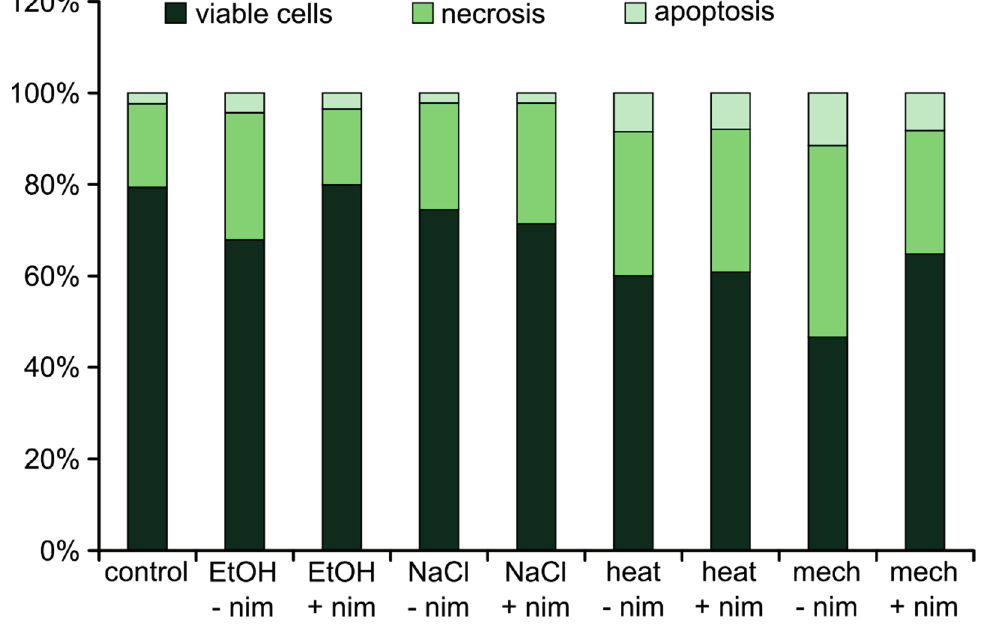
Figure 4. Flow cytometry. Values are given in % of total cells. –nim = without (w/o) nimodipine; +nim = 20 µM nimodipine; EtOH = 2% ethanol; NaCl = 150 mM NaCl; heat = 6 h, 42 °C; mech = shaking with steel